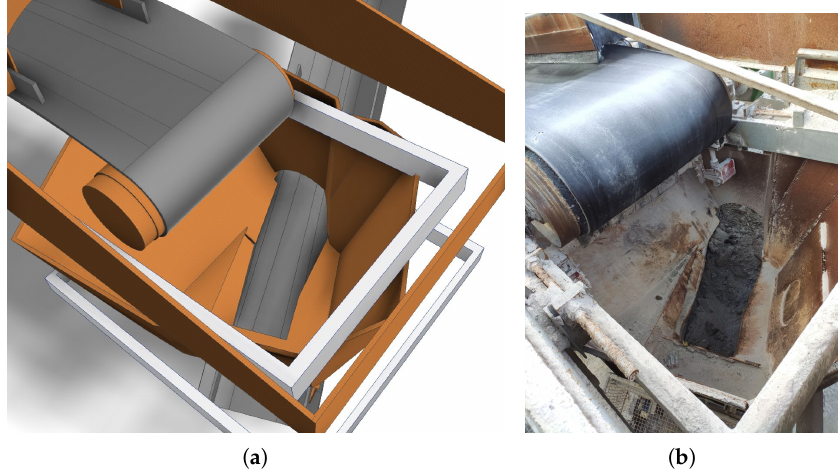
Figure 4. The inside of the transfer station: ( a ) CAD model and ( b ) existing